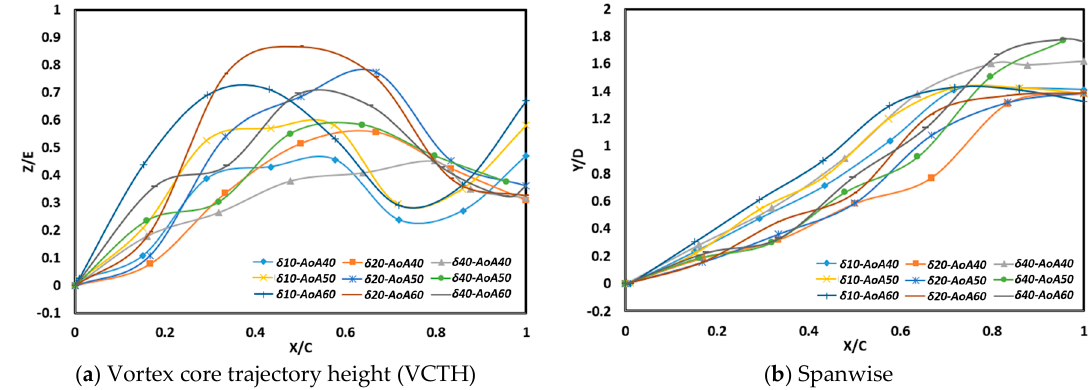
Figure 9. Vertical and horizontal vortex core trajectories.